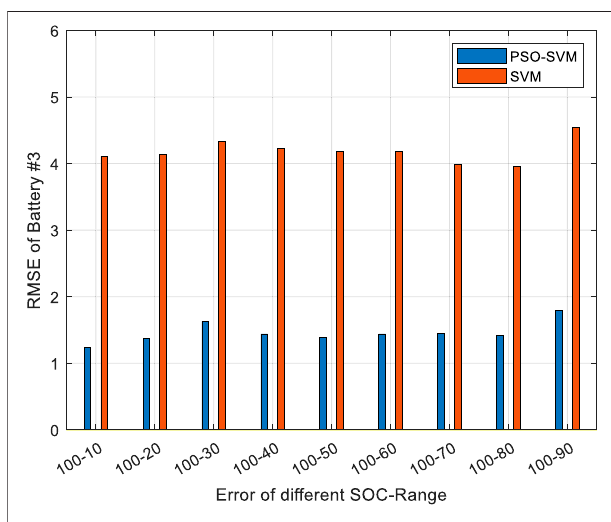
FIGURE 19 | RMSE of battery #3.